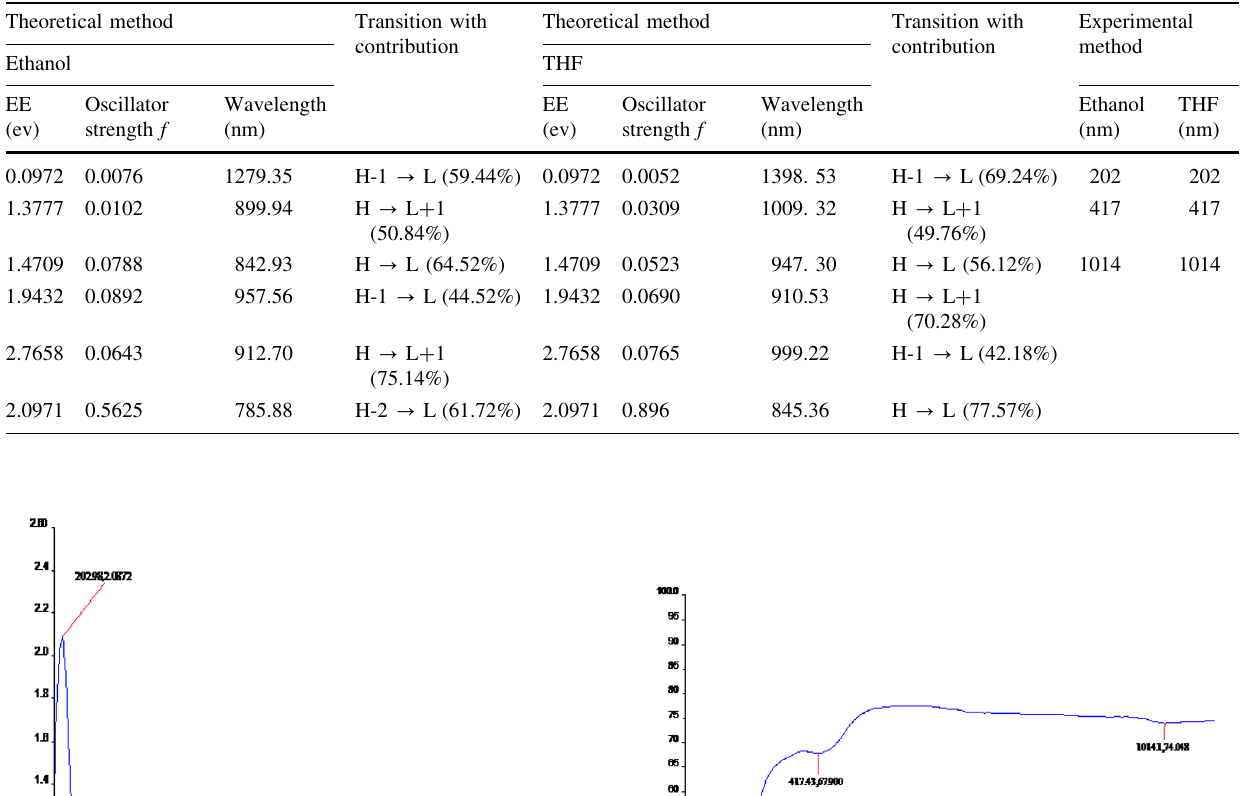
Table 6 The computed excitation energies, oscillator strength, electronic transition configuration wavelength of Curcumin using TD-DFT/ B3LYP/6-311 ?? G(d,p)